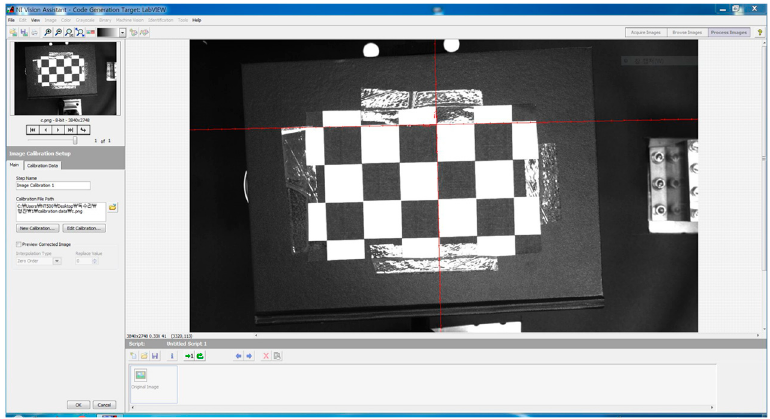
Figure 11. Snapshot of the NI Vision Assistant-based machine-vision camera calibration.